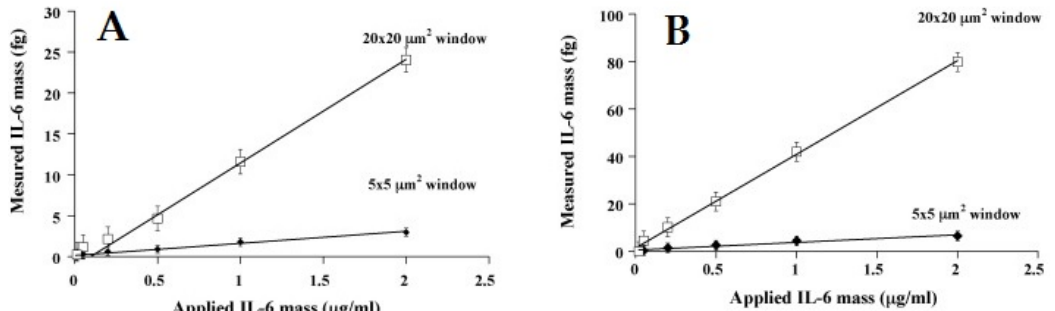
Figure 5. ( A ) SAW sensor response as measured IL-6 mass (fg / mL) vs. applied IL-6 mass ( µ g / mL), the sensor surface was modified following IL-6 immobilization through BSA. ( B ) SAW sensor response as measured IL-6 mass (fg / mL) vs. applied IL-6 mass ( µ g / mL), the sensor surface follows specific IL-6 binding through immobilization of IL-6 monoclonal antibodies. In both figures two windows of 5 × 5 µ m 2 and 20 × 20 µ m 2 were tested, sensor measurements indicated that by increasing the active surface area of the device, the sensor response increases as shown by 20 × 20 µ m 2 window in both cases, adapted with permission from [154].